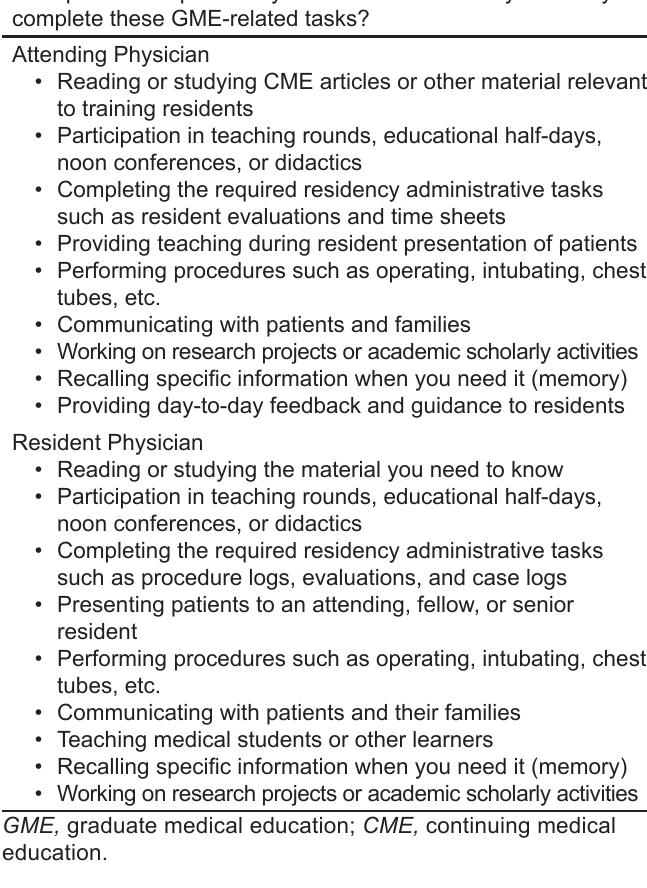
Table 1. Graduate medical education (GME)-related survey questions by GME